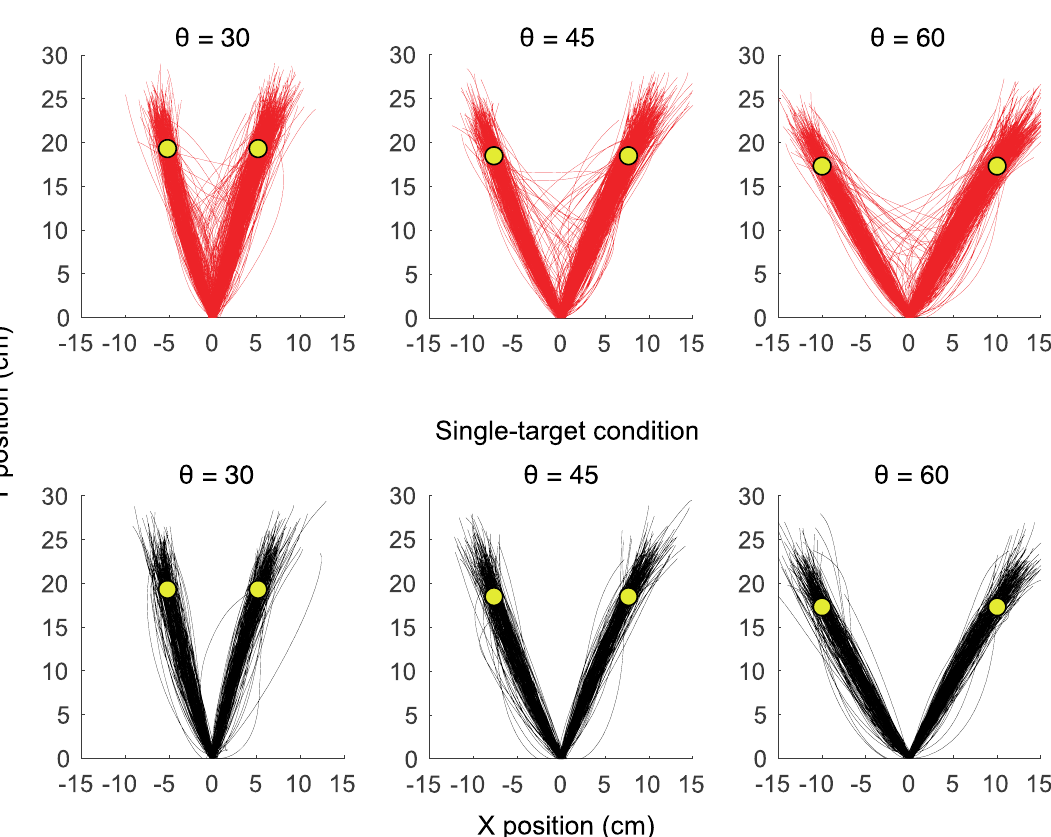
Figure 2. Trajectories in each target configuration. The cursor trajectories including all participants and all trials for each target configuration are shown. The upper row shows the double-target condition, and the lower row shows the single-target condition. In the single-target condition, participants made a linear trajectory, which is widely observed in general reaching movements. In contrast, in the double-target condition, although participants made many linear trajectories, there are trials in which participants selected a movement direction closer to the middle and trials in which the target is modified after the movement